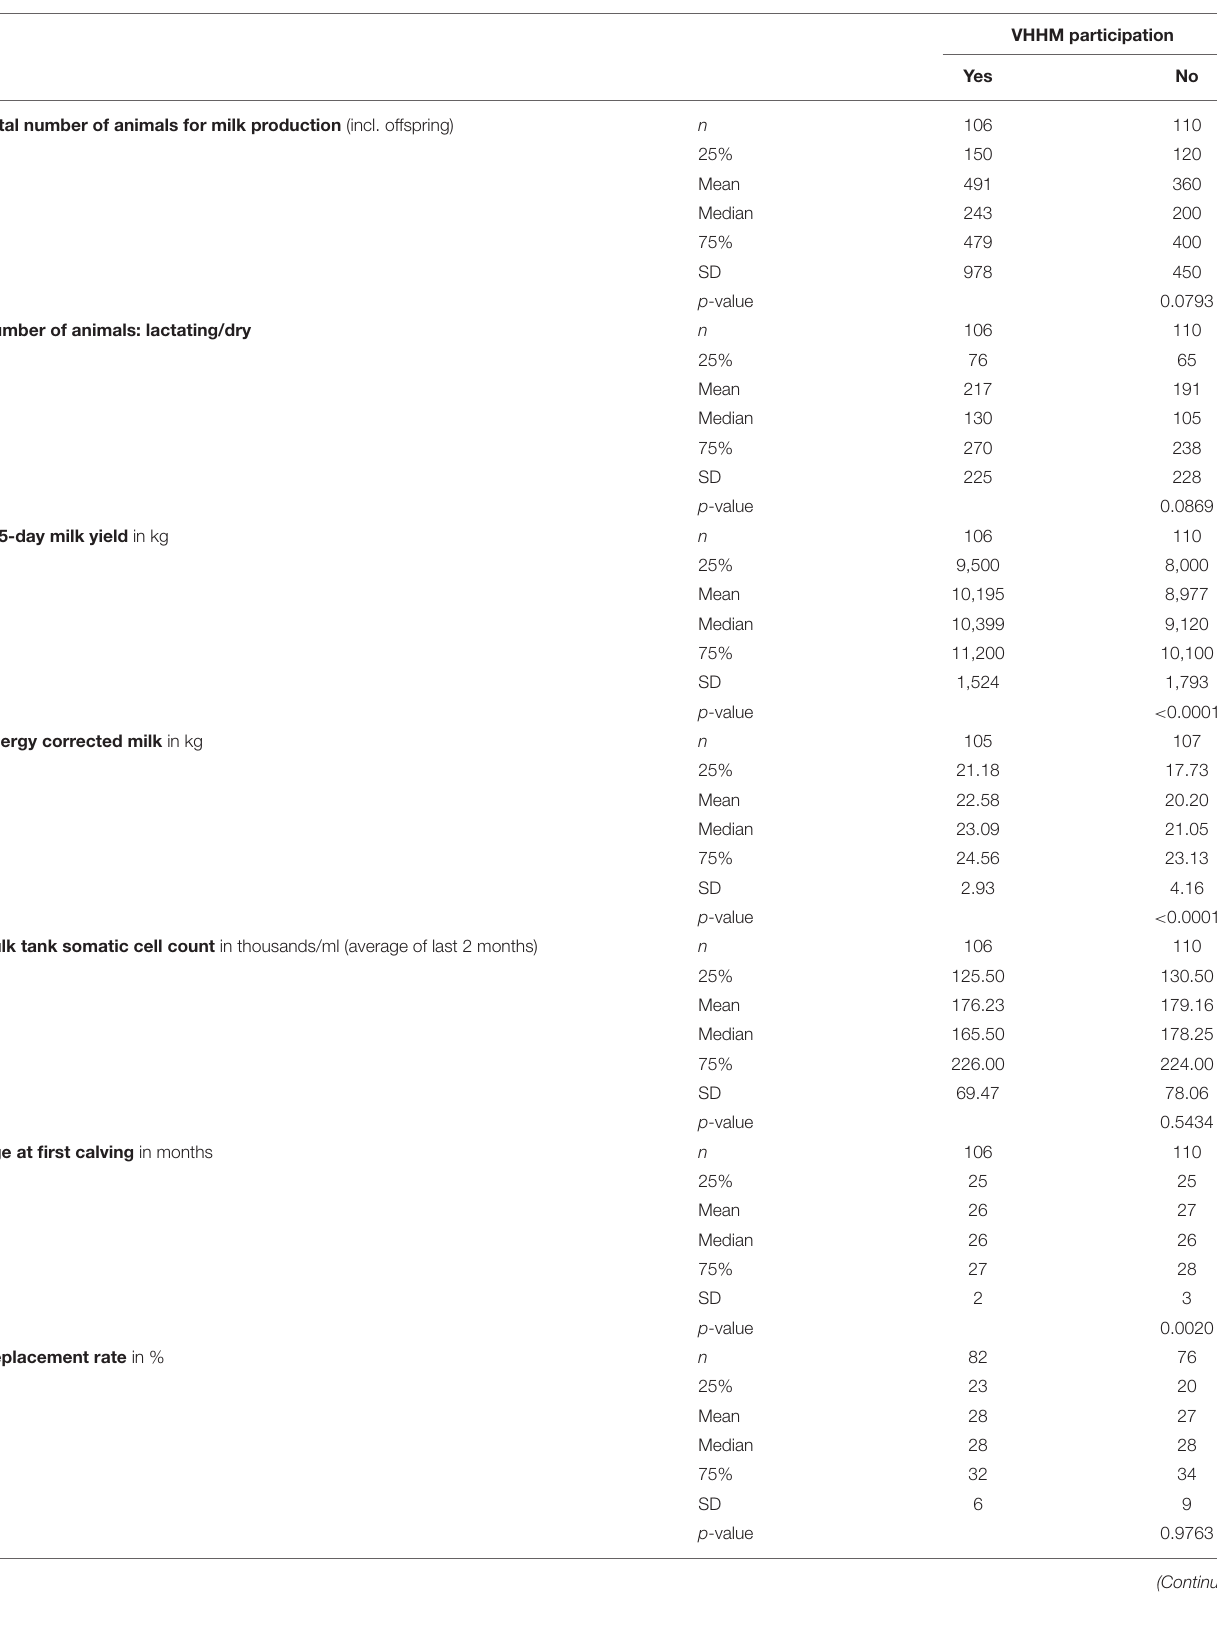
VHHM participation Yes No